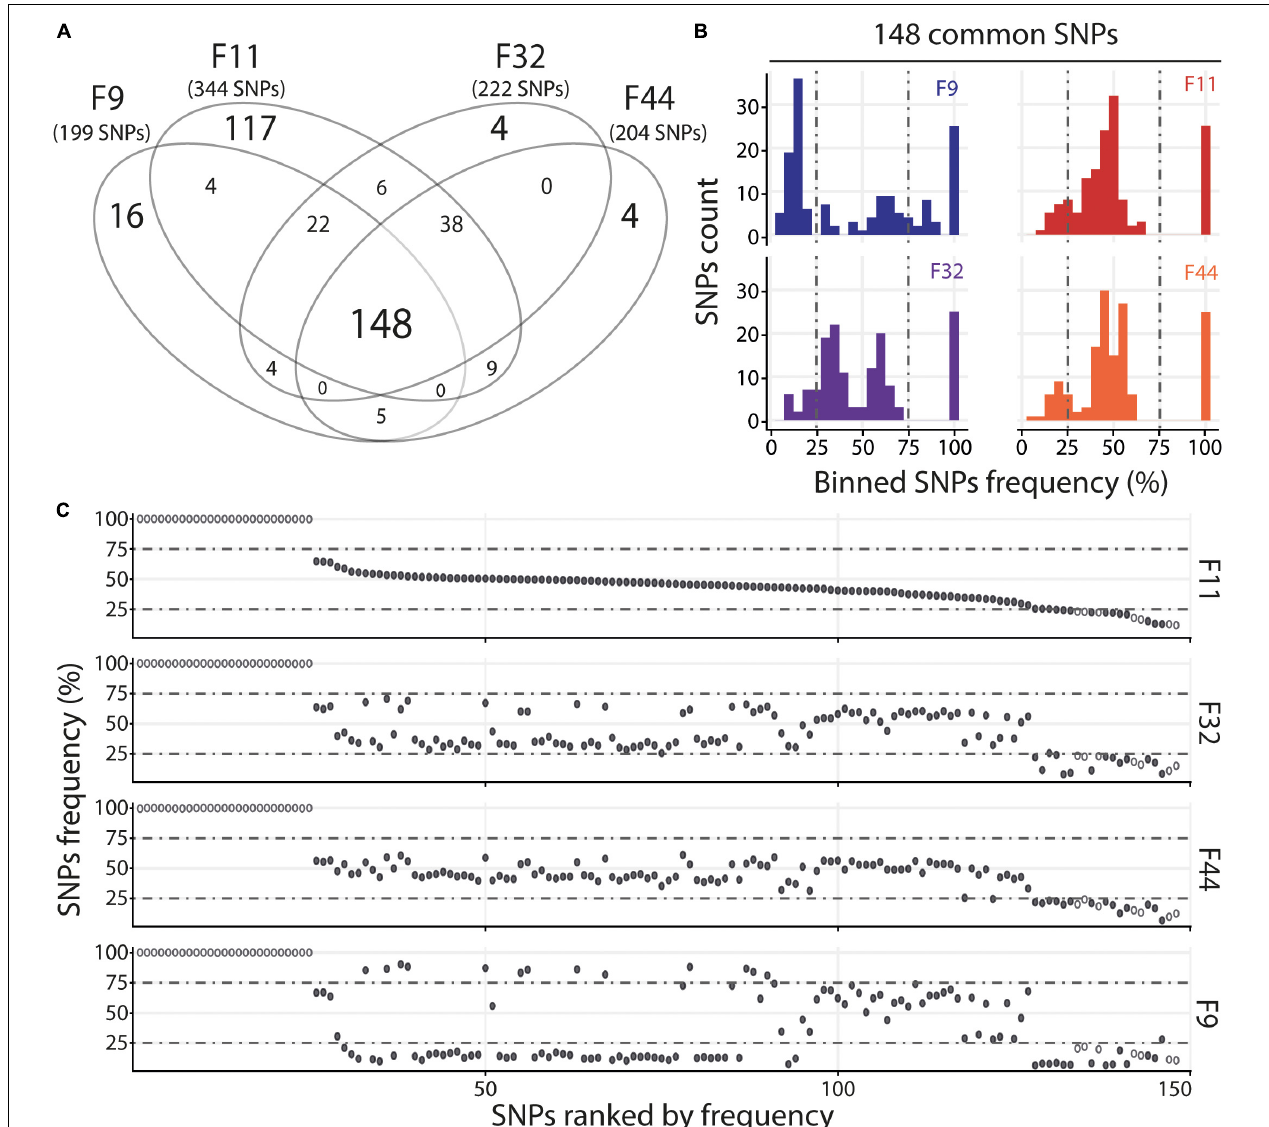
FIGURE 5 | Distinct heterogeneous viral populations infect oyster families during Atlantic experimental infection. (A) Venn diagram representation of the number of specific and common SNPs in viral populations infecting each susceptible or intermediate oyster families (F9/11/32/44). (B) The frequency distribution of common SNPs across the 4 infected families is illustrated by a histogram. SNPs are binned at 5% intervals along the x -axis, and the number of SNPs in each bin is indicated on the y -axis. (C) Common SNPs are ordered according to decreasing variant frequency in F11 family and plotted for the same position in F32, F44, and F9 families. Black and white dots correspond to SNPs with different or similar variant frequencies (difference < 5%),